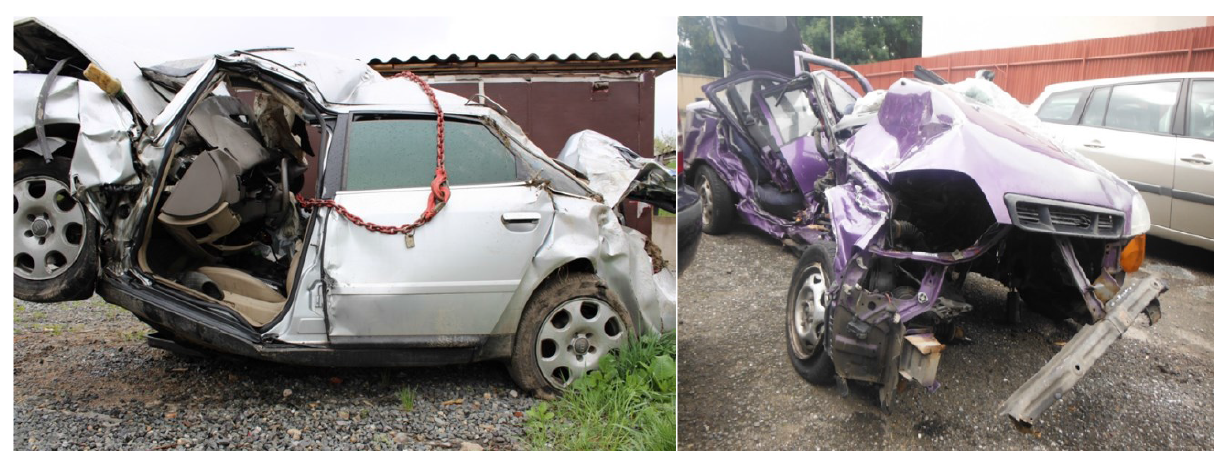
Figure 2. Damaged vehicles from accident 1 (left) and accident 2